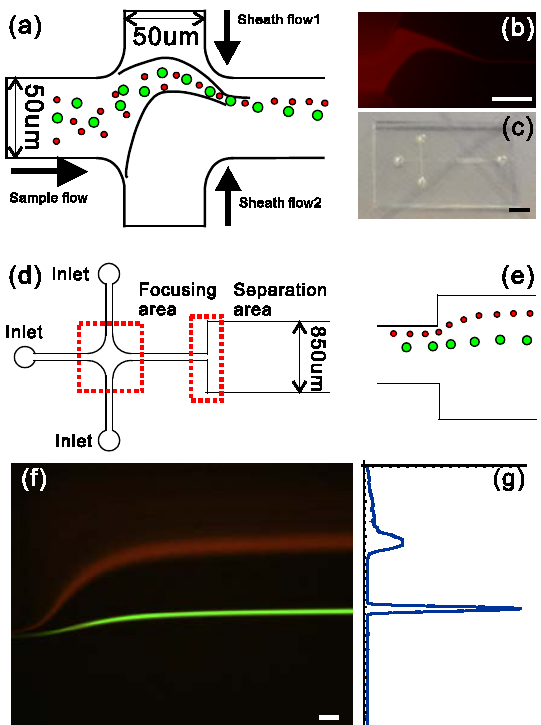
Figure 6. Application of this microfluidic prototyping fabrication for separation. ( a ) schematic diagram of the focusing area by asymmetric sheath flows (the flow rate of sample flow, sheath flow 1 and sheath flow 2 are 2 , 9 and 45 µ L · min − 1 , respectively); ( b ) the asymmetric focusing area through the invent fluorescent microscope (the scale bar is 50 µ m); ( c ) the image of the microfluidic chip (the scale bar is 4 mm); ( d ) the design of the microfluidic chip for separation; ( e ) the schematic diagram of the separation area; ( f ) the image of the separation of big microparticles (green, Φ 9.9 µ m) and small microparticles (red, Φ 1.0 µ m) through the invented fluorescent microscope (the scale bar is 50 µ m); and ( g ) the distribution of the particles according to the intensity of